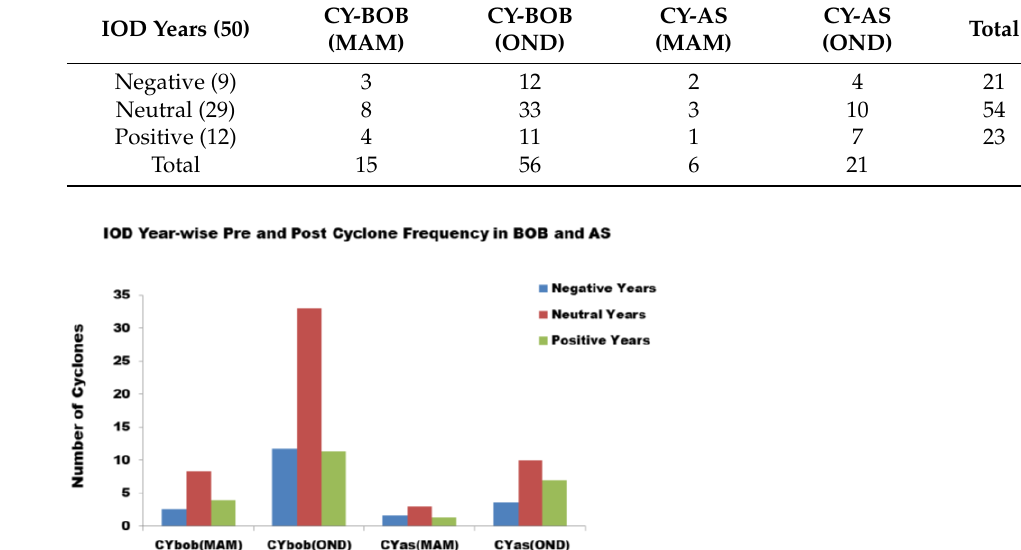
Table 2. Number of cyclones from 1971 to 2020 for negative, neutral and positive IOD years.